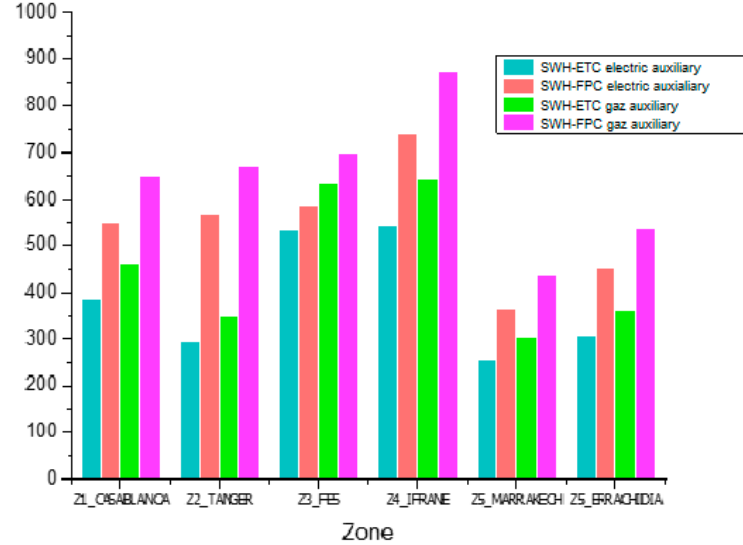
Figure 14. Annual energy of the backup system for standard demand of hot water.